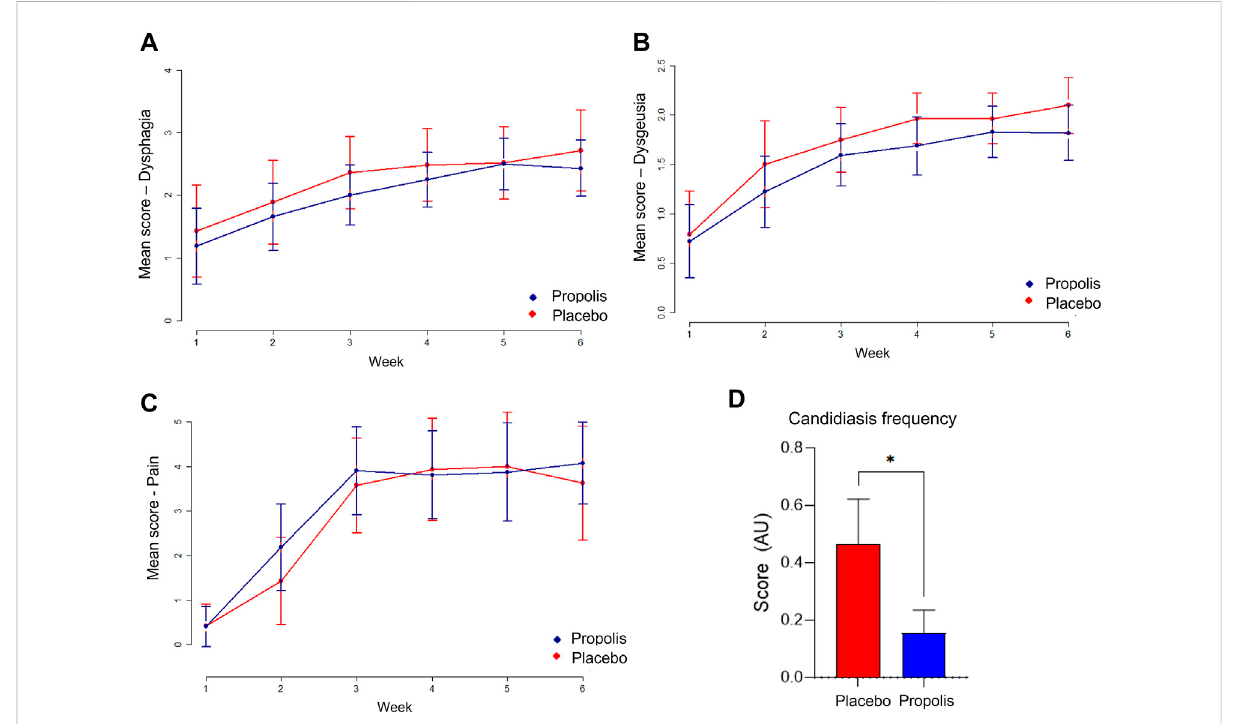
FIGURE 4 Weekly mean score of dysphagia (A) , dysgeusia (B) , pain (C) and bar diagram showing candidiasis frequency (D)